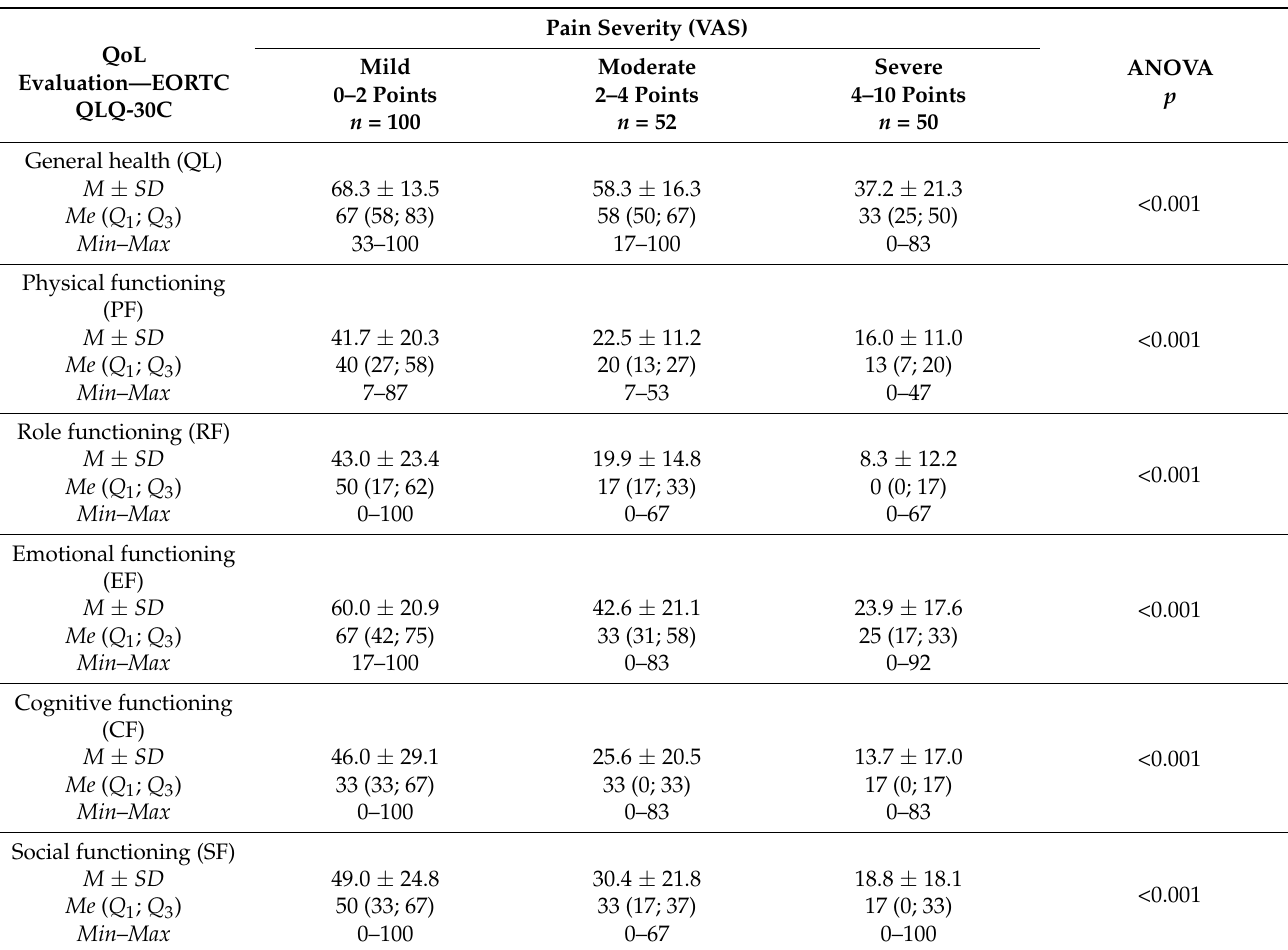
Table 9. Quality of life (EORTC QLQ-BR23 scores) in patients differing in terms of pain severity scores, with analysis of variance